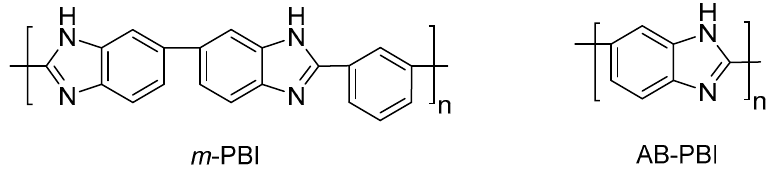
Figure 3. Chemical structures m -PBI and AB-PBI.